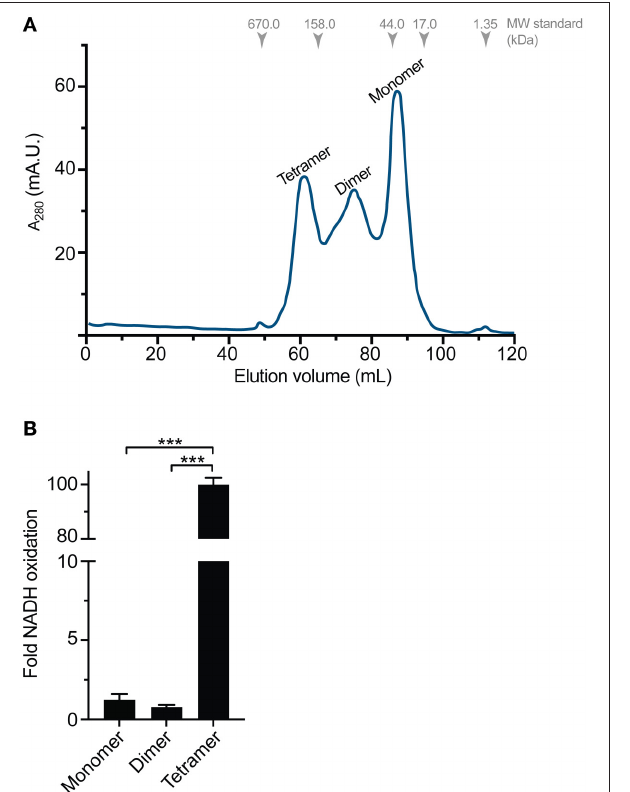
and 0.86 × 10 − 7 ( ± 0.1 × 10 − 7 ) moles NADH/min/mg for the dimer. The consumption rate of the tetrameric oligomer was 1.1 ×